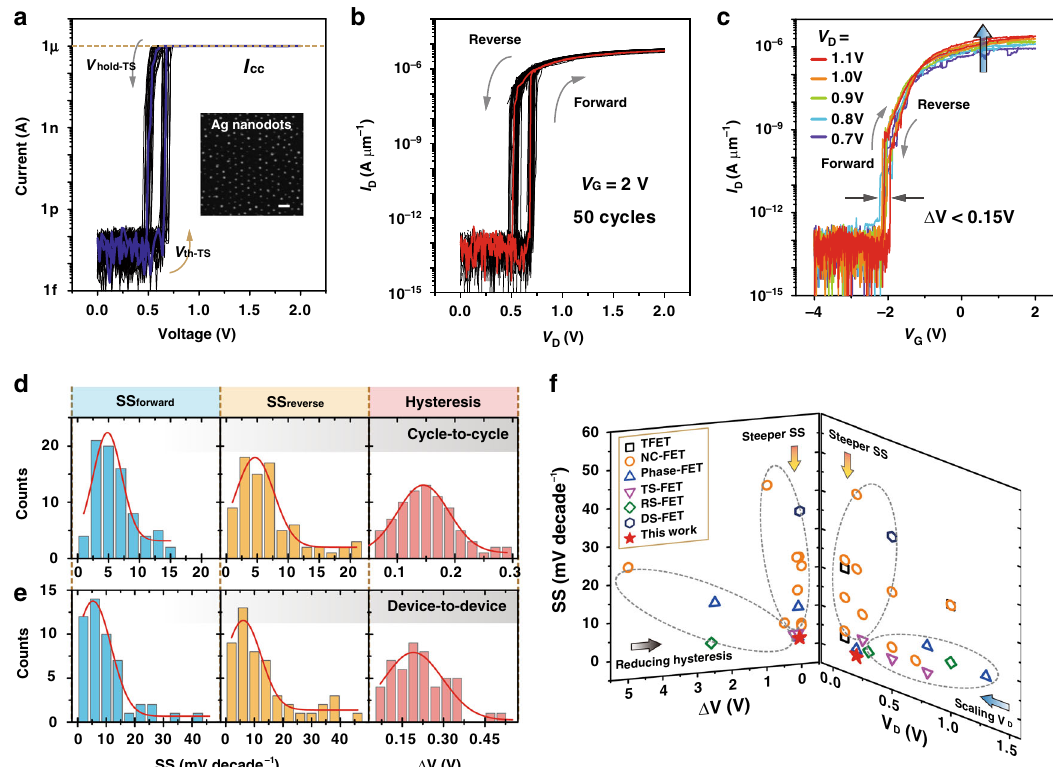
Fig. 5 ATS-FET with much-reduced hysteresis and SS. a Typical I – V characteristics of the TS device based on highly ordered Ag nanodots in 30 cycles ( I cc = 1 μ A). The inset is a scanning electron microscopy (SEM) image of highly ordered Ag nanodots. b Output characteristics of the ATS-FET with the newly presented TS at a V G of 2V in 50 cycles. 2D MoS 2 channel (channel width: 2.2 μ m; channel length: 1.8 μ m). c Transfer characteristics ( I D – V G ) of the ATS-FET with the newly presented TS at a V D ranging from 0.7 to 1.1V. d , e Statistical distributions of SS forward , SS reverse , and hysteresis ( Δ V ) of the ATS-FET in d cycle- to-cycle and e device-to-device variations. f Comparisons of SS – hysteresis (left) and SS – V D (right) in different steep-slope FETs, including the TFET 8,39,40 ,